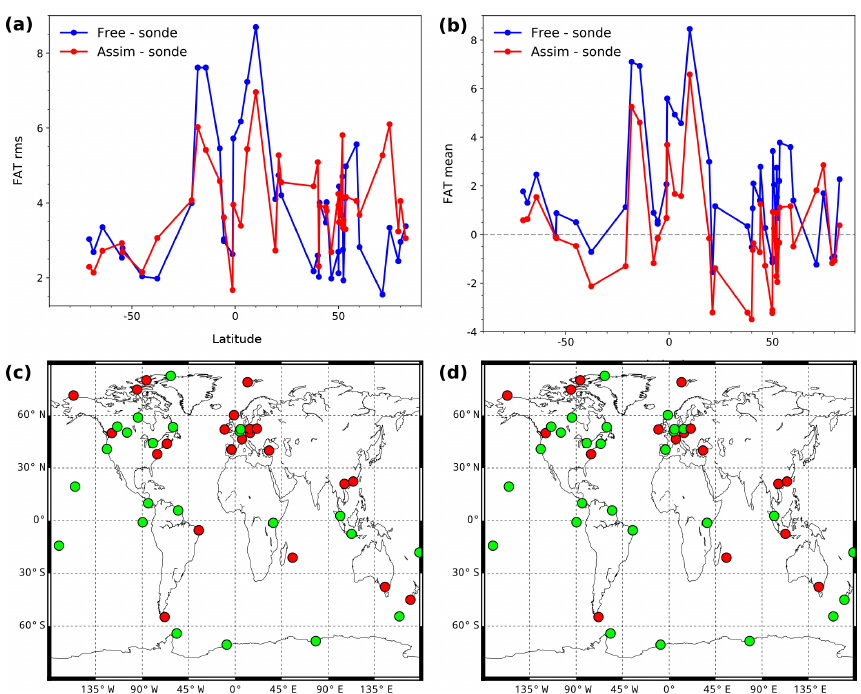
Figure 6. The FAT rms (a) and mean (b) per station as a function of latitude. The blue line gives the results for the free model run compared to sondes. The red line gives the results for the assimilated O 3 fields compared to sondes. Panel (c) : green dots indicate stations where | rms | < | rms | , and red dots where | rms | > | rms | . Panel (d) : green dots indicate stations where | mean assim free assim free red dots where | mean assim | > | mean free | . Only results for stations with at least 10 collocations have been